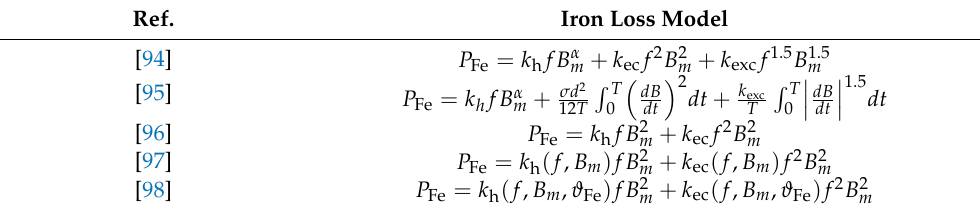
Table 3. Common iron loss models.